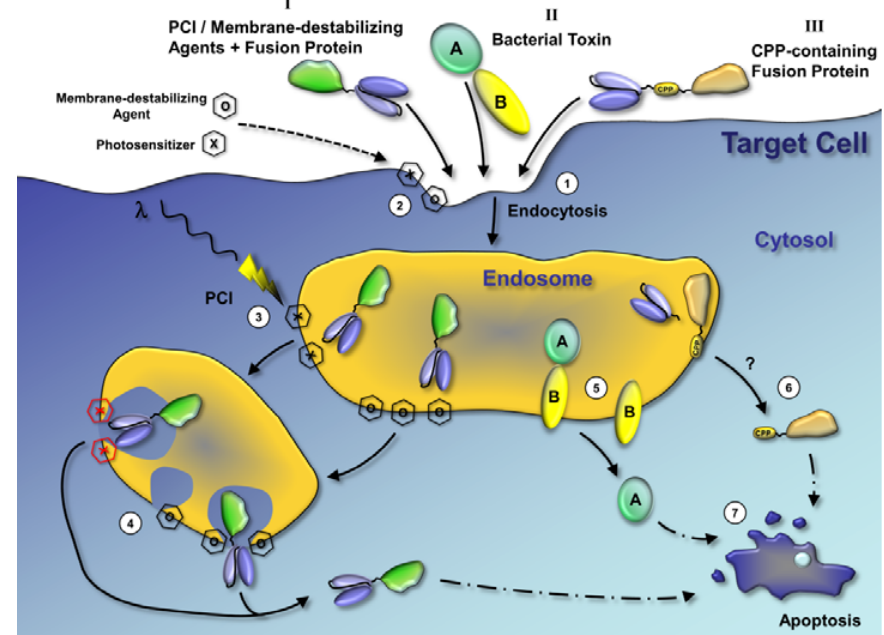
Figure 1. Mechanisms of endosomal escape. The three most relevant mechanisms of endosomal escape are depicted in this figure: Endosomal escape of drugs by photochemical internalization (PCI) or membrane-destabilizing agents (I), endosomal escape of bacterial toxins (II), and cell penetrating peptides (CPP)-mediated release of drugs from endosomes (III). Endosomal escape by PCI, membrane-destabilizing agents and CPPs has been described for a variety of drugs and the fusion proteins in this figure serve only as examples. ( 1 ) The first step for all three mechanisms is the binding of fusion proteins or bacterial toxins to specific cell surface receptors and the internalization into the target cell by endocytosis. ( 2 ) Endosomal escape of fusion proteins by PCI or membrane-destabilizing agents (I): Photosensitizers (hexagon marked with an X, required for PCI) and membrane- destabilizing agents (hexagon marked with an O) are co-administered with fusion proteins and internalize in the plasma membrane and co-internalize with the fusion proteins in endosomes. ( 3 ) The photosensitizers are activated by light (red hexagons marked with X) and induce reactive oxygen species production. ( 4 ) Both activated photosensitizers and high local concentrations of membrane-destabilizing agents result in endosomal leakage and rupture. The fusion protein is released to the cytosol. ( 5 ) Endosomal release of bacterial toxins (II): Bacterial toxins usually contain one protein or a protein domain (marked as B in the figure) that binds the cell surface receptor and initiates translocation of the catalytic protein or other protein domain (marked as A in the figure) through the endosomal membrane into the cytosol. ( 6 ) CPP-mediated endosomal release: CPPs mediate the translocation of conjugated drugs or proteins through the endosomal membrane. The detailed mechanisms are unknown and most likely vary for different CPPs. The cell-targeting domain of a fusion protein may be released before the CPP is active in the endosome. ( 7 ) All three described mechanisms result in the release of the fusion proteins in the cytosol. The active domains act on their intracellular targets and induce various effects, such as apoptosis, in the target